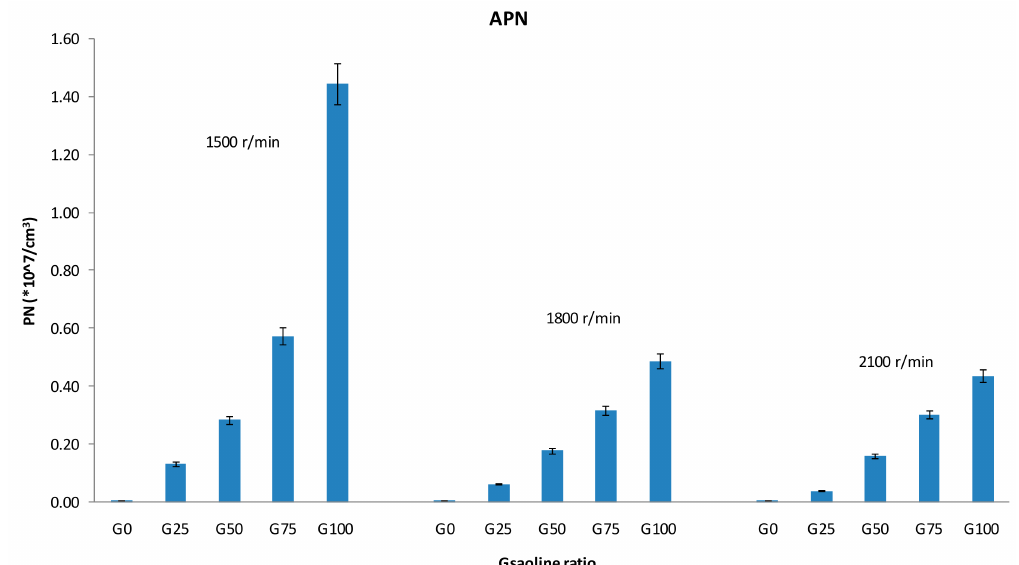
Figure 7. Accumulation mode particle number with R e for di ff erent speed (The direct injection timing is 180 ◦ CA BTDC. The ignition timing is MBT. The intake manifold absolute pressure is 42 kPa).